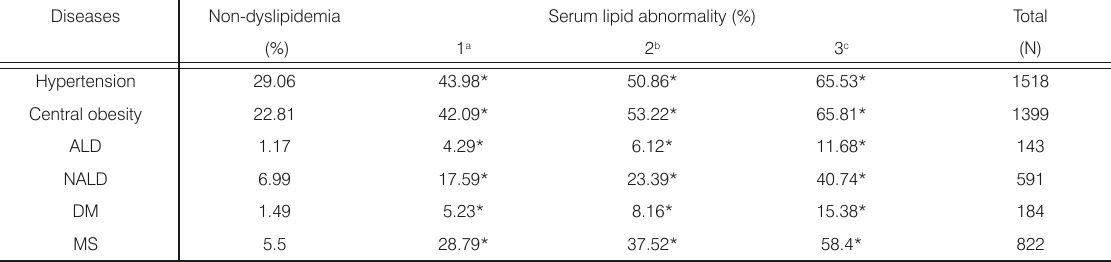
Figure 2. Age trends for mean TC/HDL-C in females (dashed lines) and males (solid lines).